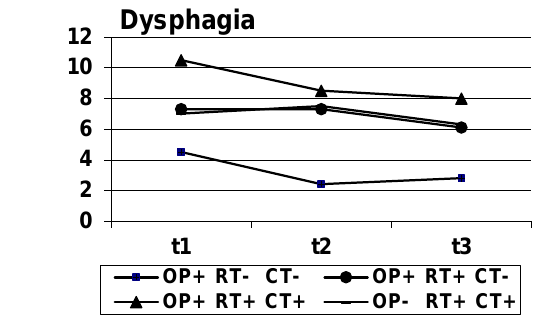
Figure 1. Dysphagia mean scores, broken down by diagnosis ( left ) and treatment ( right ); OP+, OP-: surgery yes/no; RT+, RT-: radiotherapy yes/no; CT+, CT-: chemotherapy yes/no.